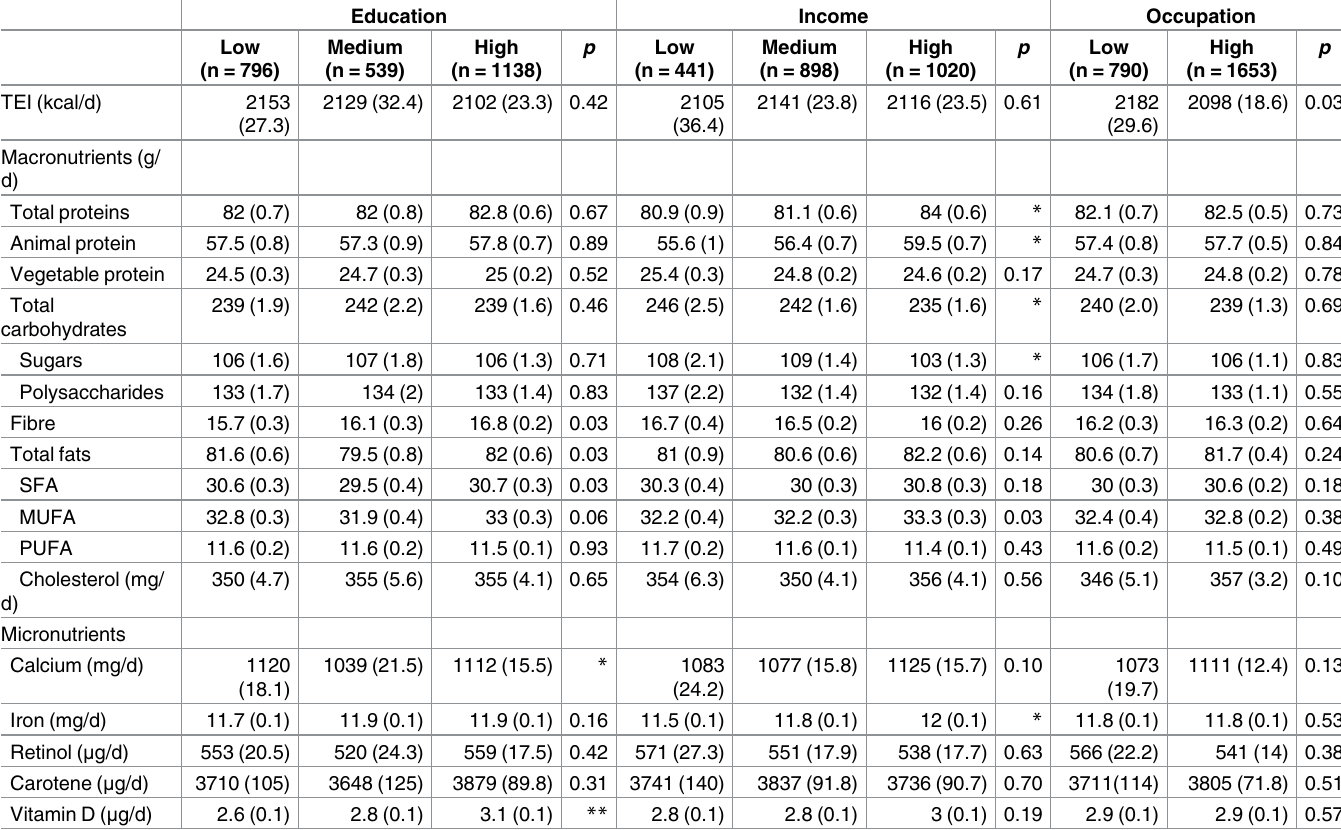
Table 4. Energy and nutrient intake (mean & SE) among men from “Bus Sante´” study, Geneva, Switzerland, years2005–2012,by socioeconomic status indicator, multivariable adjusted. Education Income